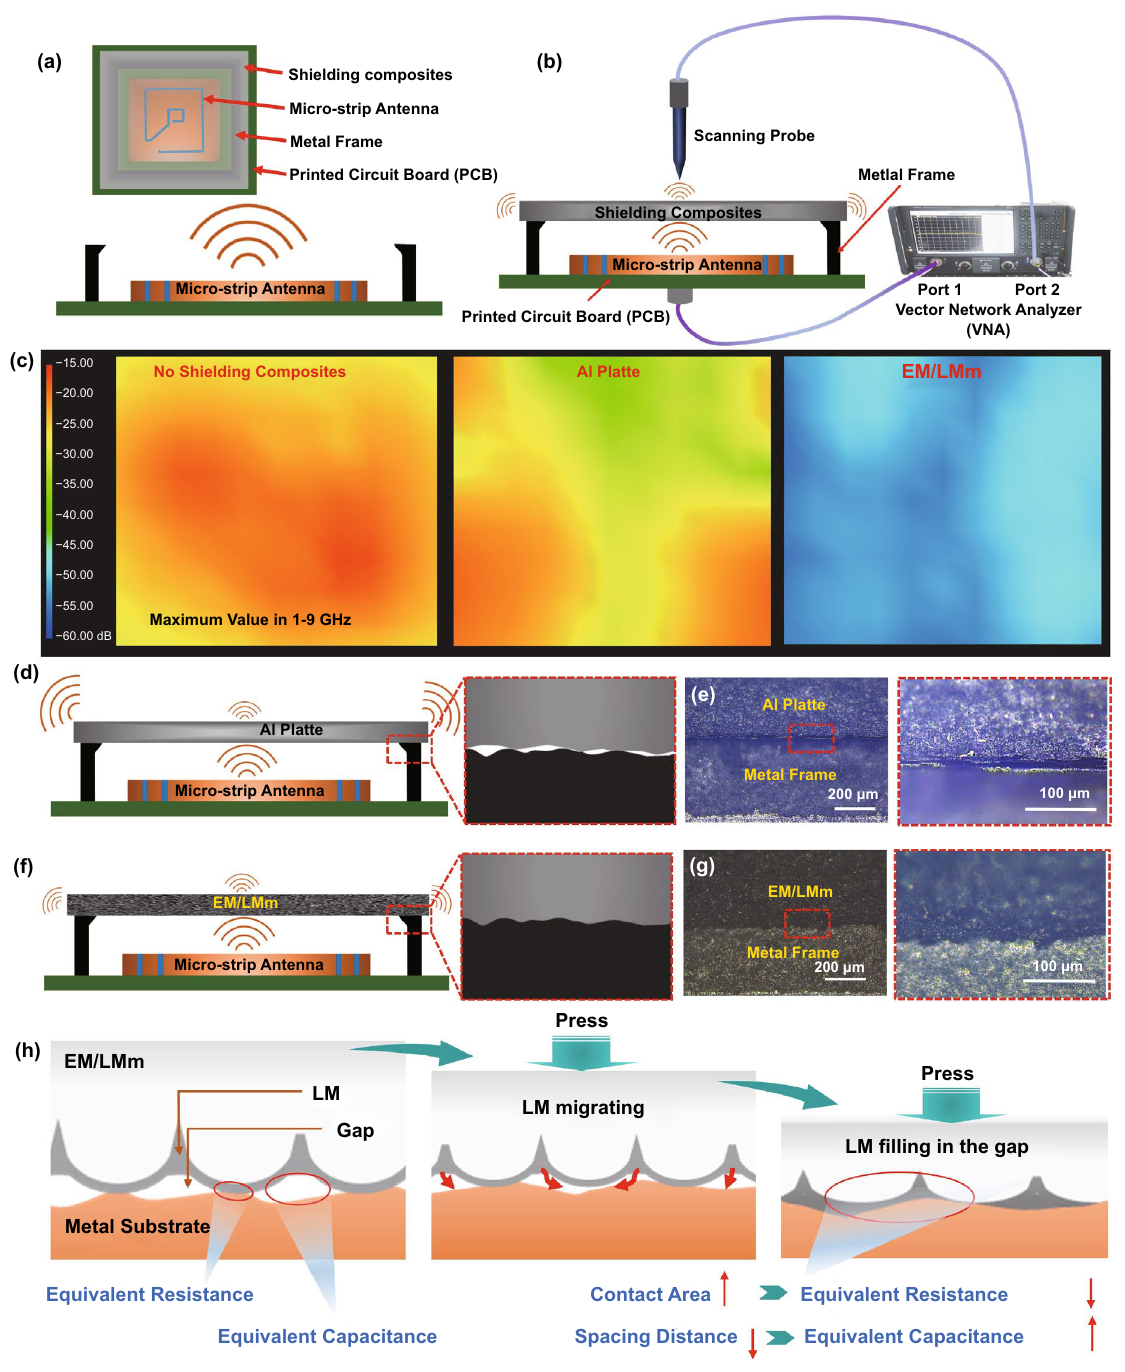
Fig. 5 NF‑SE performance of EM/LMm and the comparison of EM/LMm with other LM and shielding materials. a , b Schematic depicting the NF‑SE testing principle and system. This testing model is mainly to measure the near field EMI SE performance of shielding materials by testing the relative electric and magnetic signals. c NF‑SE mapping images of bare antenna, shielding with Al plate and shielding with EM/ LMm (maximum value in every point among 1–9 GHz). d , e Schematic of shielding model with Al plate, and the optical images of the interface between the metal frame and Al plate. The holes were caused by the hard surface of the metal frame and Al plate. f , g Schematic of shielding model with EM/LMm. The optical images between the metal frame and EM/LMm show a tight interface. h The schematic diagram of interface electromagnetic self‑sealing mechanism of